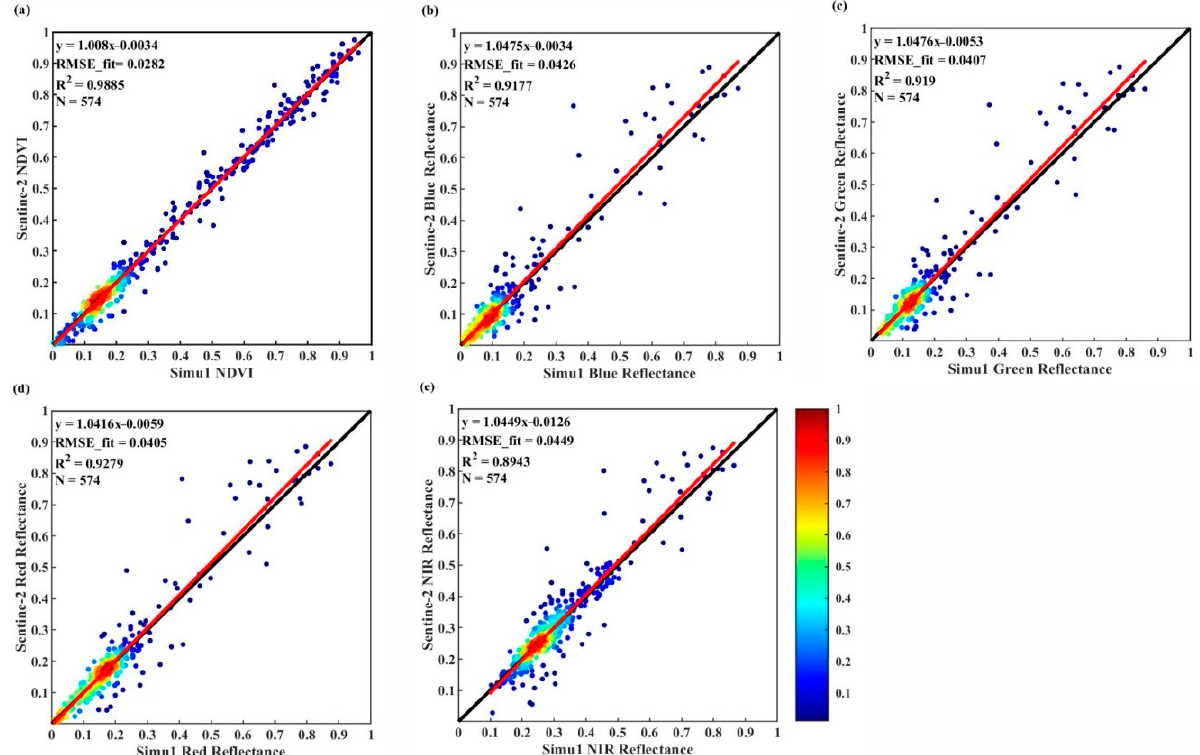
Figure 7. Density scatterplots between the reconstructed and the cloud-free Sentinel-2 L2A NDVI series and the surface reflectance time series in 4 bands over the 10 typical vegetation samples in 2020. ( a ) NDVI; ( b – e ) surface reflectance in blue, green, red and NIR band, respectively.